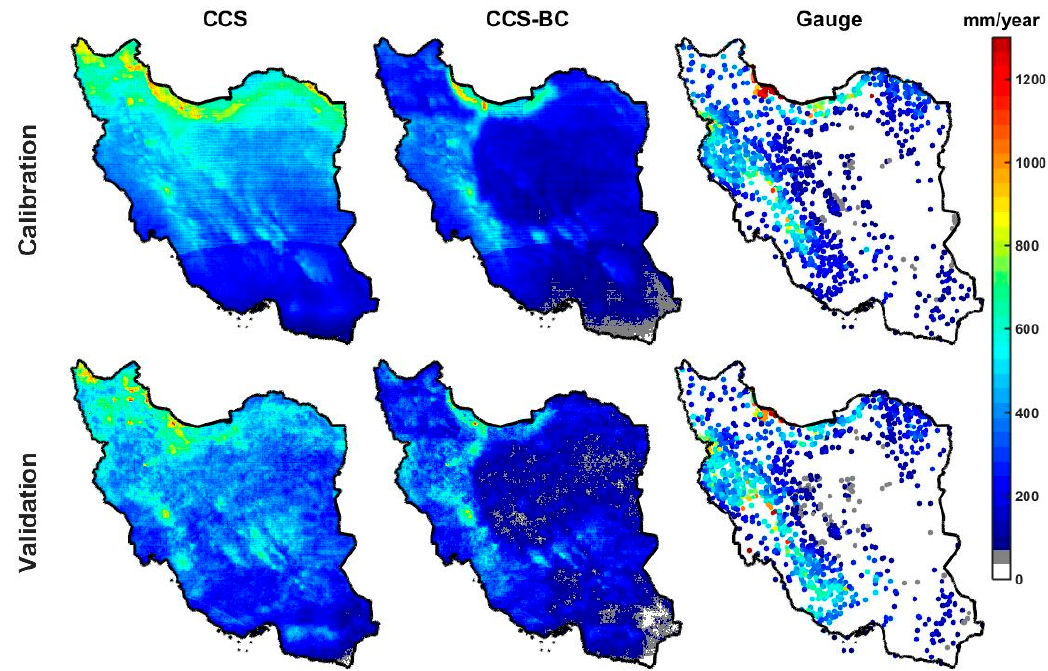
Figure 3. Mean annual precipitation for the CCS, PERSIANN-CCS-Bias-Corrected (CCS-BC) and gauge for the calibration and validation periods.